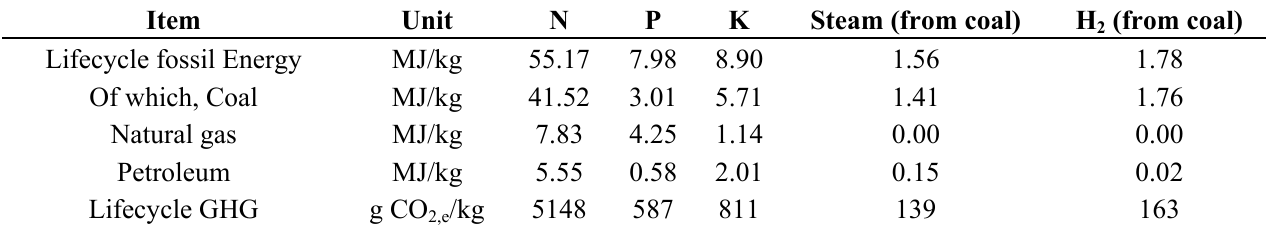
Table 4. Life-cycle fossil energy and GHG results for nutrients and chemicals